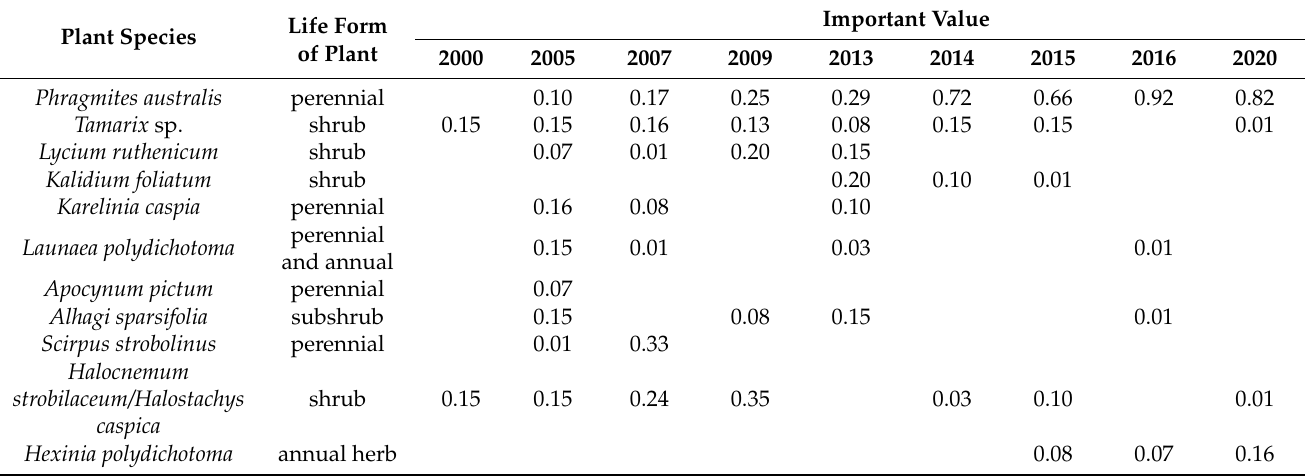
Table 2. List of important values of species present in quadrats for each year (2000,